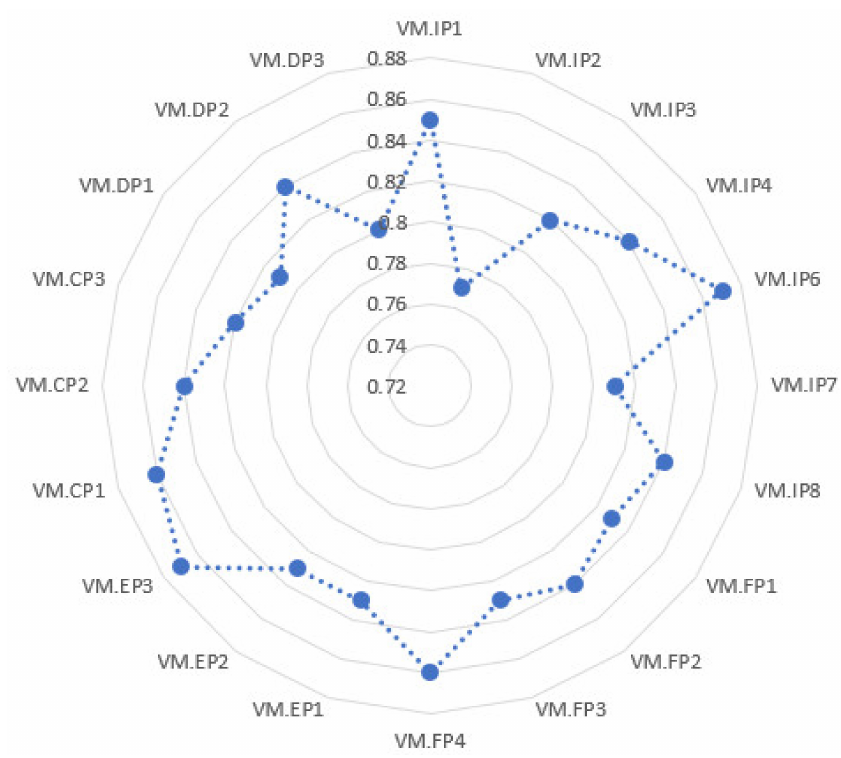
Figure 10. Relative important index ( RII ) levels for value management (VM) activities. Table 3. Gap analysis between the importance and practice levels of VM